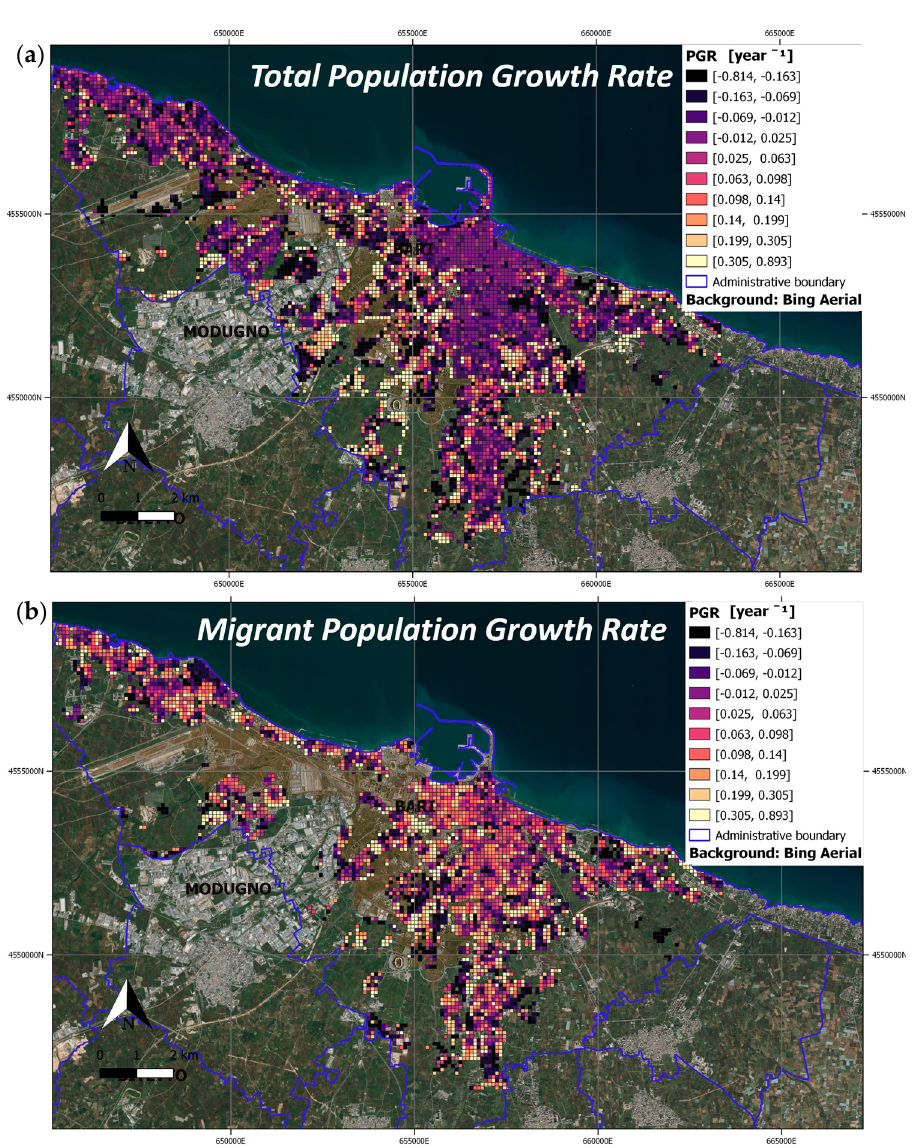
Figure 16. Population Growth Rate from October 2011–January 2020, with respect to: ( a ) The total population; ( b ) the migrant population.